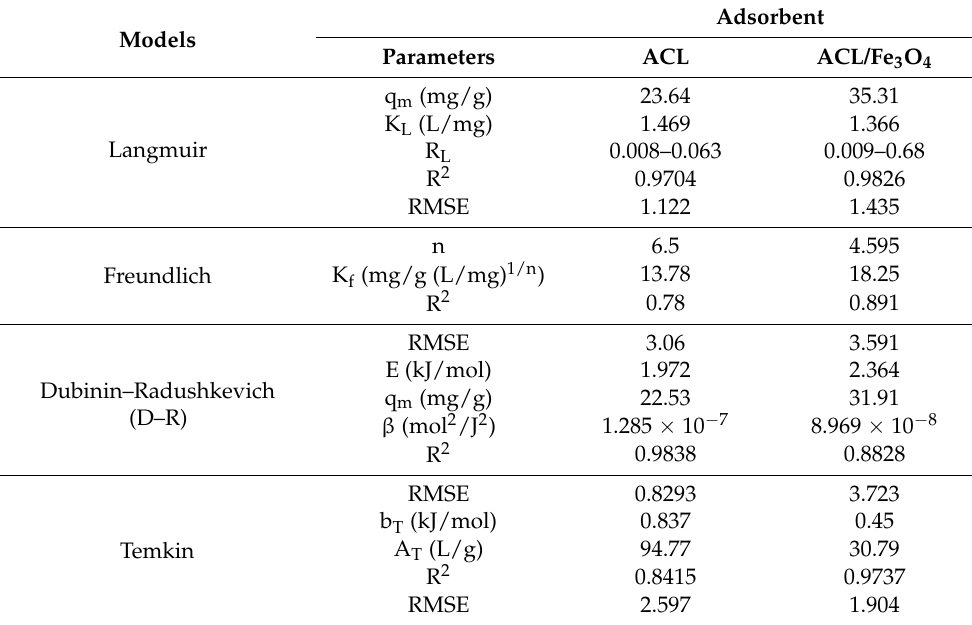
Table 2. Constant isotherms and parameters determined for the CV dye adsorption